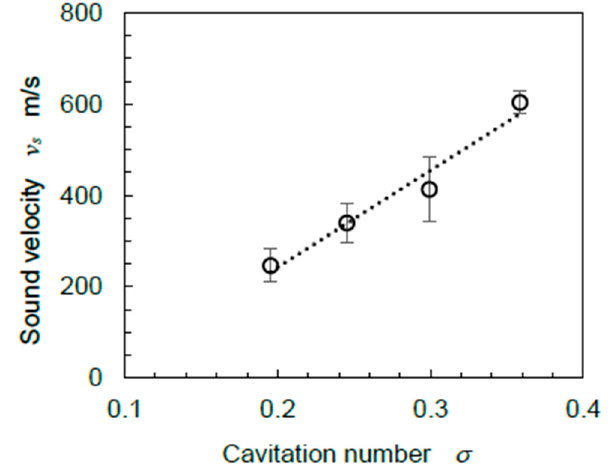
Figure 19. Sound velocity in cavitating flow field through Venturi tube changing with cavitation number.